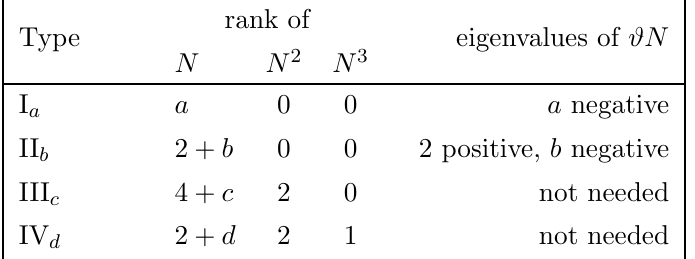
Table 1 . Classification of the arising limits and singularities occurring in the complex moduli space of Calabi-Yau